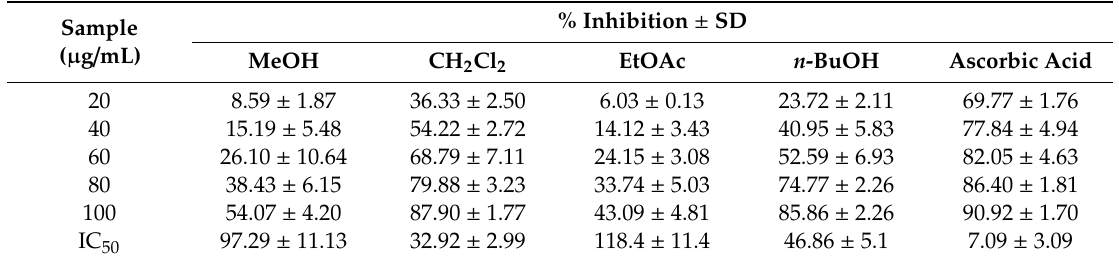
Table 4. Antioxidant e ff ects of the A. vacillans extract using superoxide scavenging.